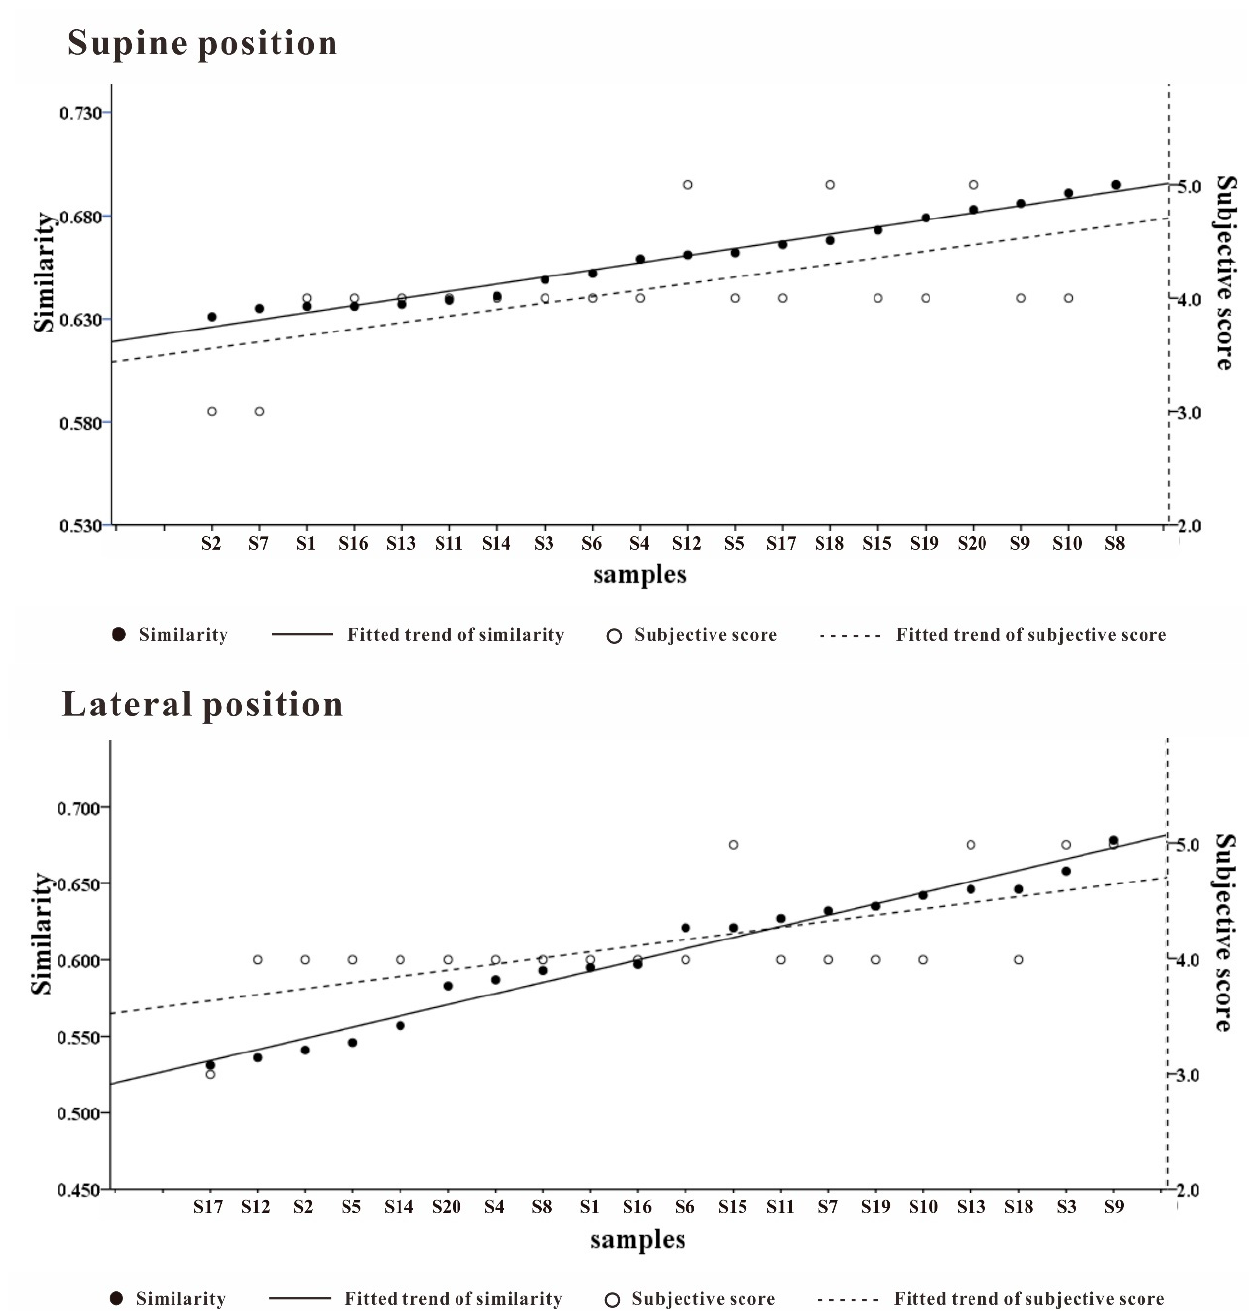
Figure 14. Ideal pressure distribution similarity ranking and subjective evaluation trend. According to Equation (11), the comprehensive weighted comfort evaluation in each recumbent position was calculated. The comparative subjective score is shown in Figure 15. The two values showed a high degree of consistency. The comfort weight value of each partition was highly